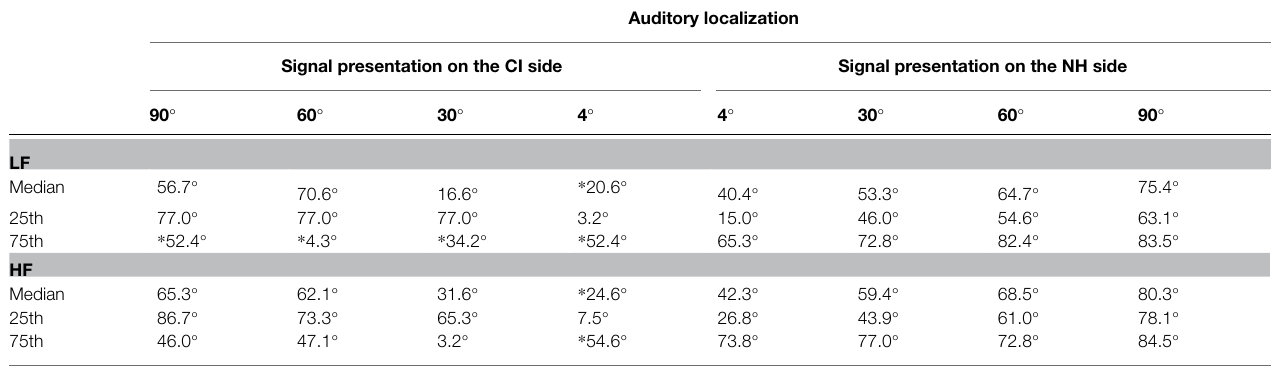
TABLE 2 | Descriptive statistics for